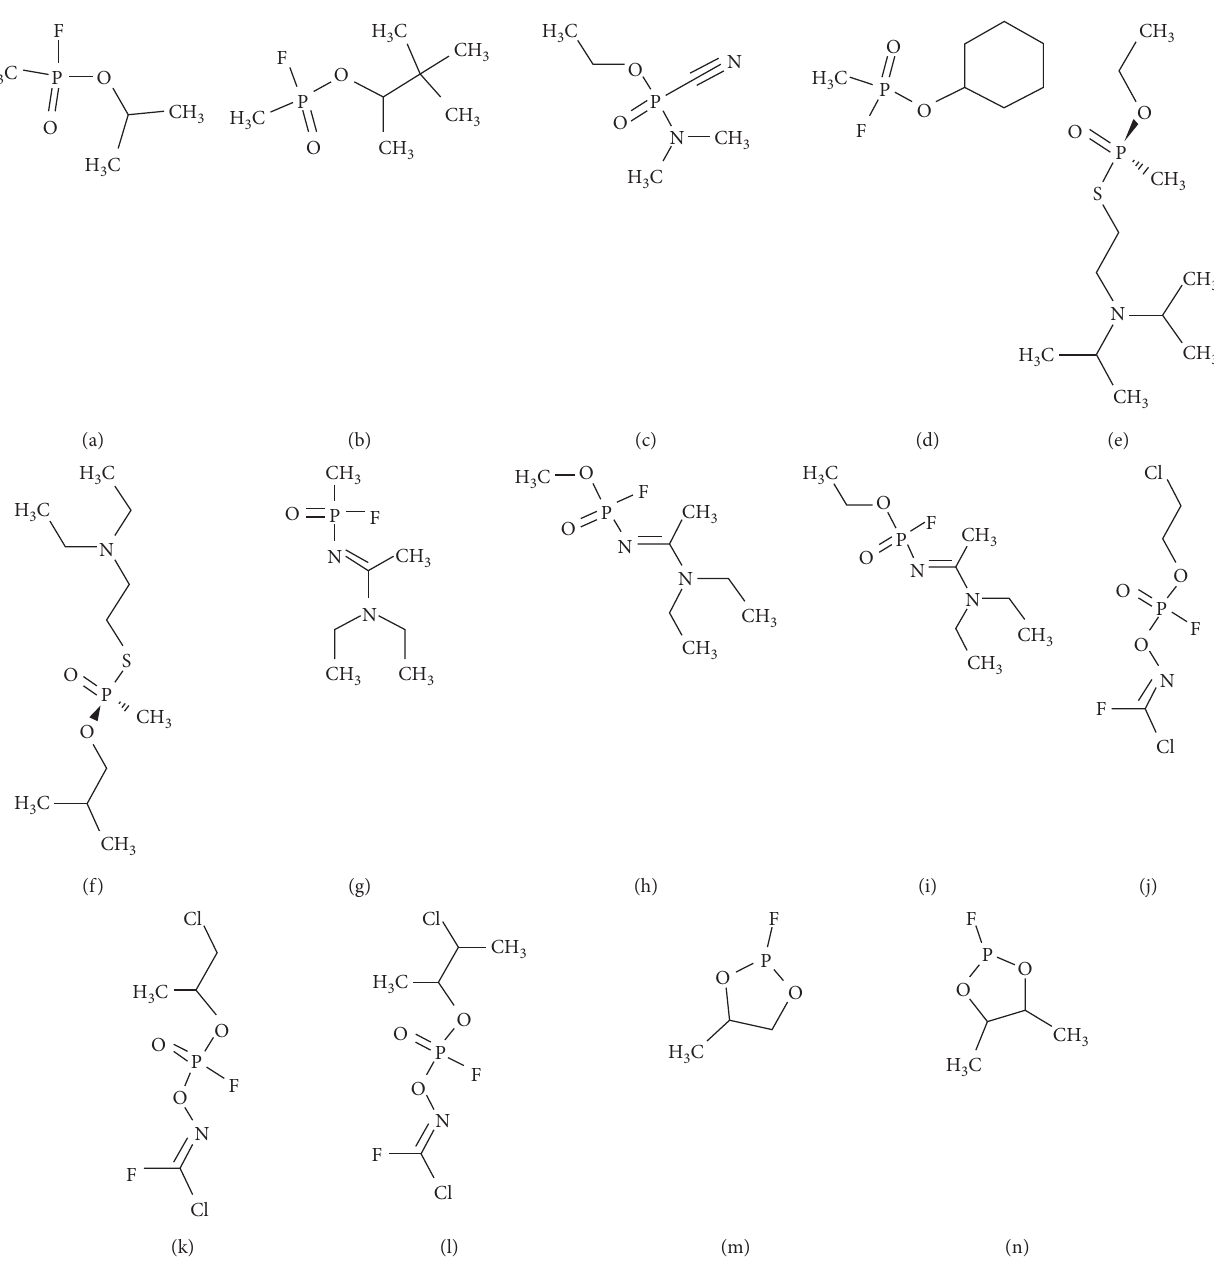
Figure 1: Chemical structure of G-series agents: (a) sarin, (b) soman, (c) tabun, and (d) cyclosarin; (e) V-series agent, VX; (f) VR (substance-33); chemical structures of A-series according to Dr. Mirzayanov: (g) A230, (h) A232, and (i) A234; chemical structures of A- series according Hoenig: (j) A230, (k) A232, and (l) A234; plausible and speculated chemical structures of Novichok: (m) Novichok-5 and (n) Novichok-7. For creating the chemical structures, ChemSketch software was